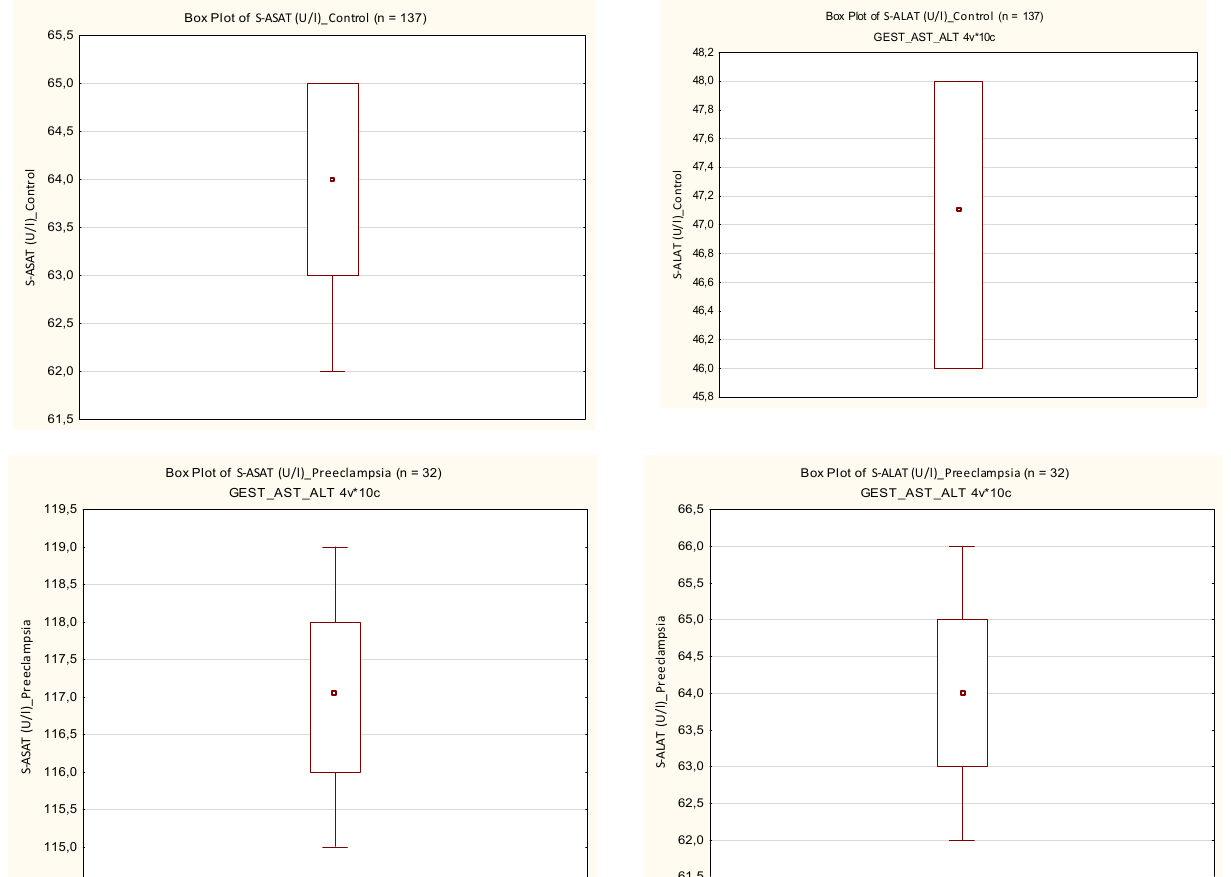
Fig. 1. Changes in the activity of aminotransferases in the blood of cows at preeclampsia (M ±